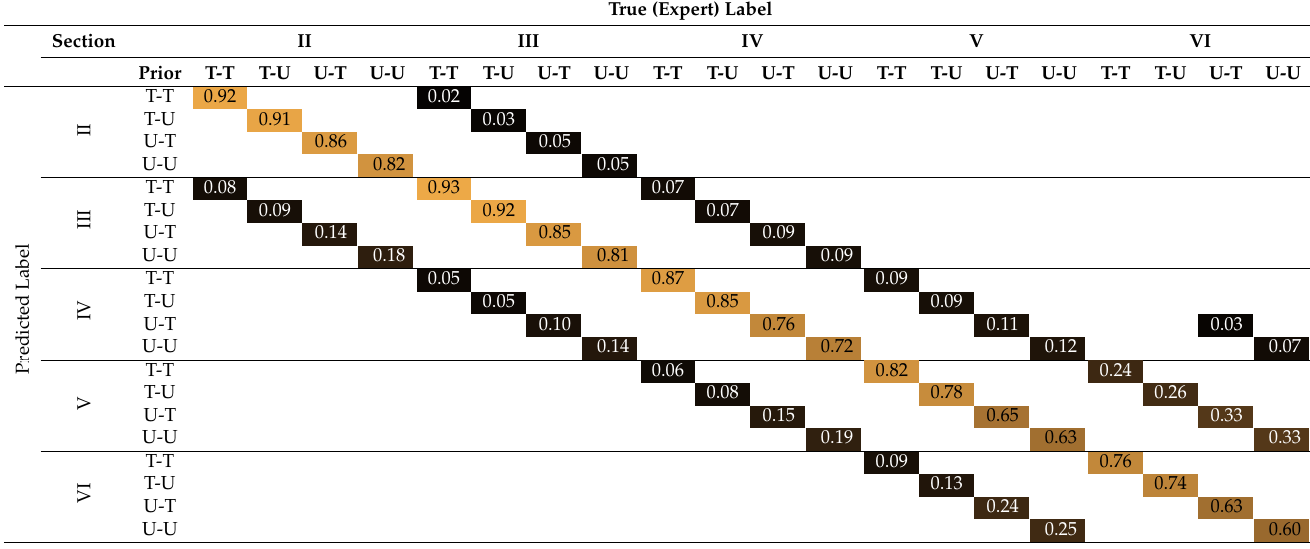
Table 2. Confusion matrix of predicted and expert labeled sections.